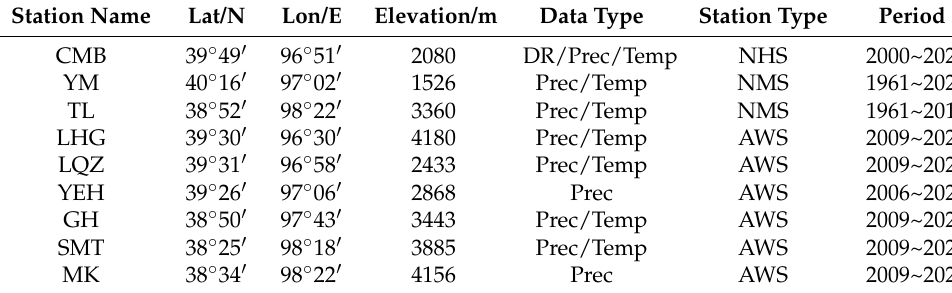
Table 1. Information on meteorological and hydrological stations in the USR and adjacent